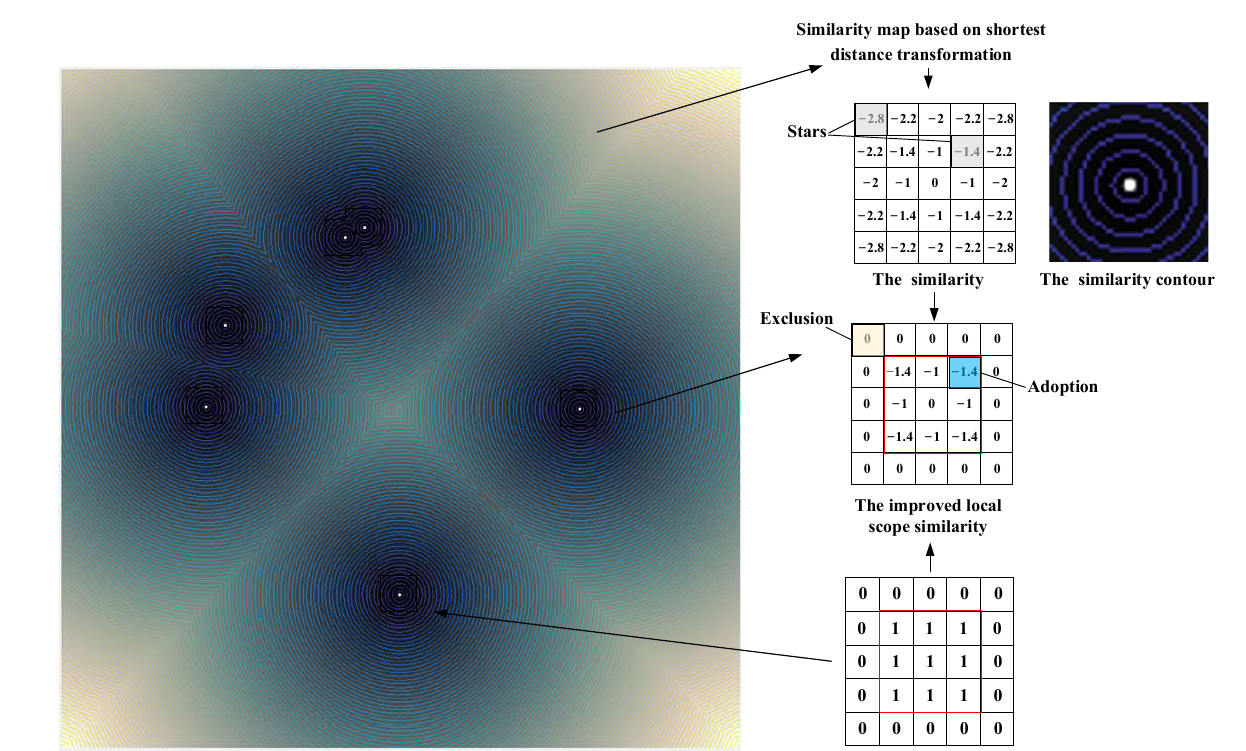
Figure 7. Illustration of similarity based on the shortest distance transformation and local scope improvement.